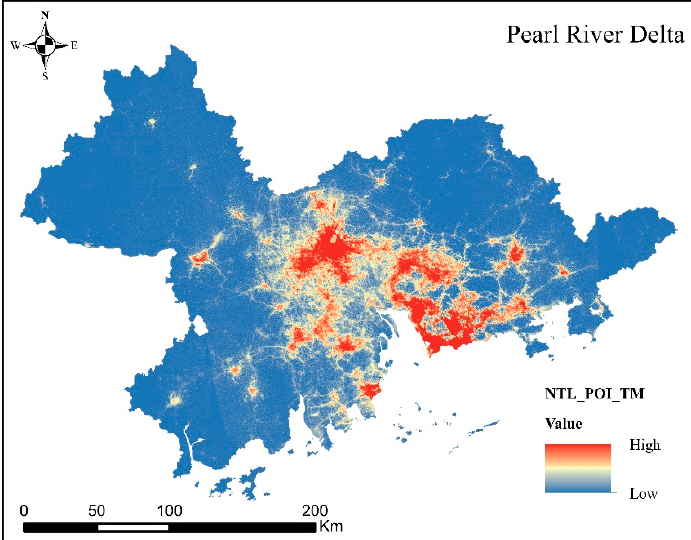
Figure 11. Fusion results of NTL, POI, and TMG data in PRD.